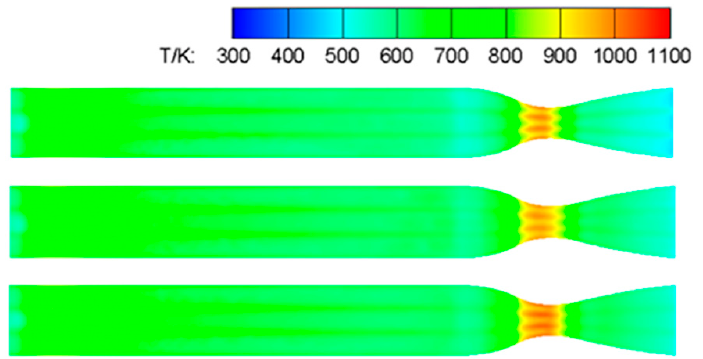
Figure 13. Temperature contour on the inner wall of rib height under 0.75 mm ( top ), 1.00 mm ( middle ), and 1.25 mm ( bottom ).